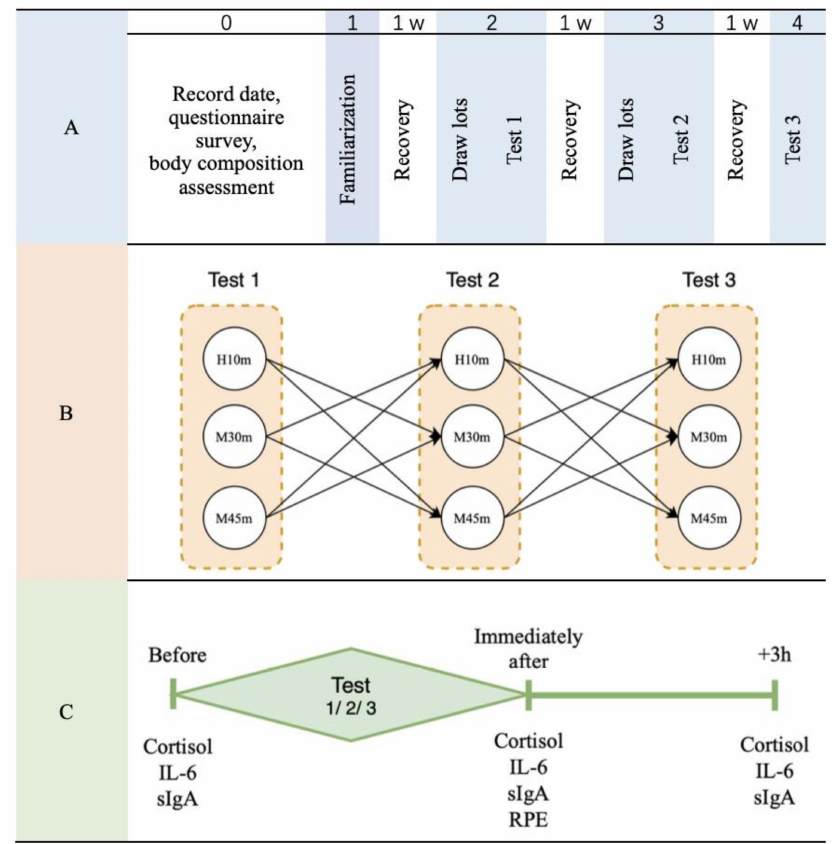
Figure 1. Experimental group assignment. ( A ): experiment; ( B ): exercise trial; ( C ): sample collection; 1 W: a week; H10m: high-intensity exercise for 10 min (>80% HRmax); M30m: moderate-intensity exercise for 30 min (60–80% maximum heart rate [HRmax]); M45m: moderate-intensity exercise for 45 min (60–80% HRmax); Before: before the exercise; Immediately after: immediately after the exercise; +3 h: 3 h post-exercise; IL6: Interleukin-6; sIgA: saliva Immunoglobulin A; RPE: rate of perceived